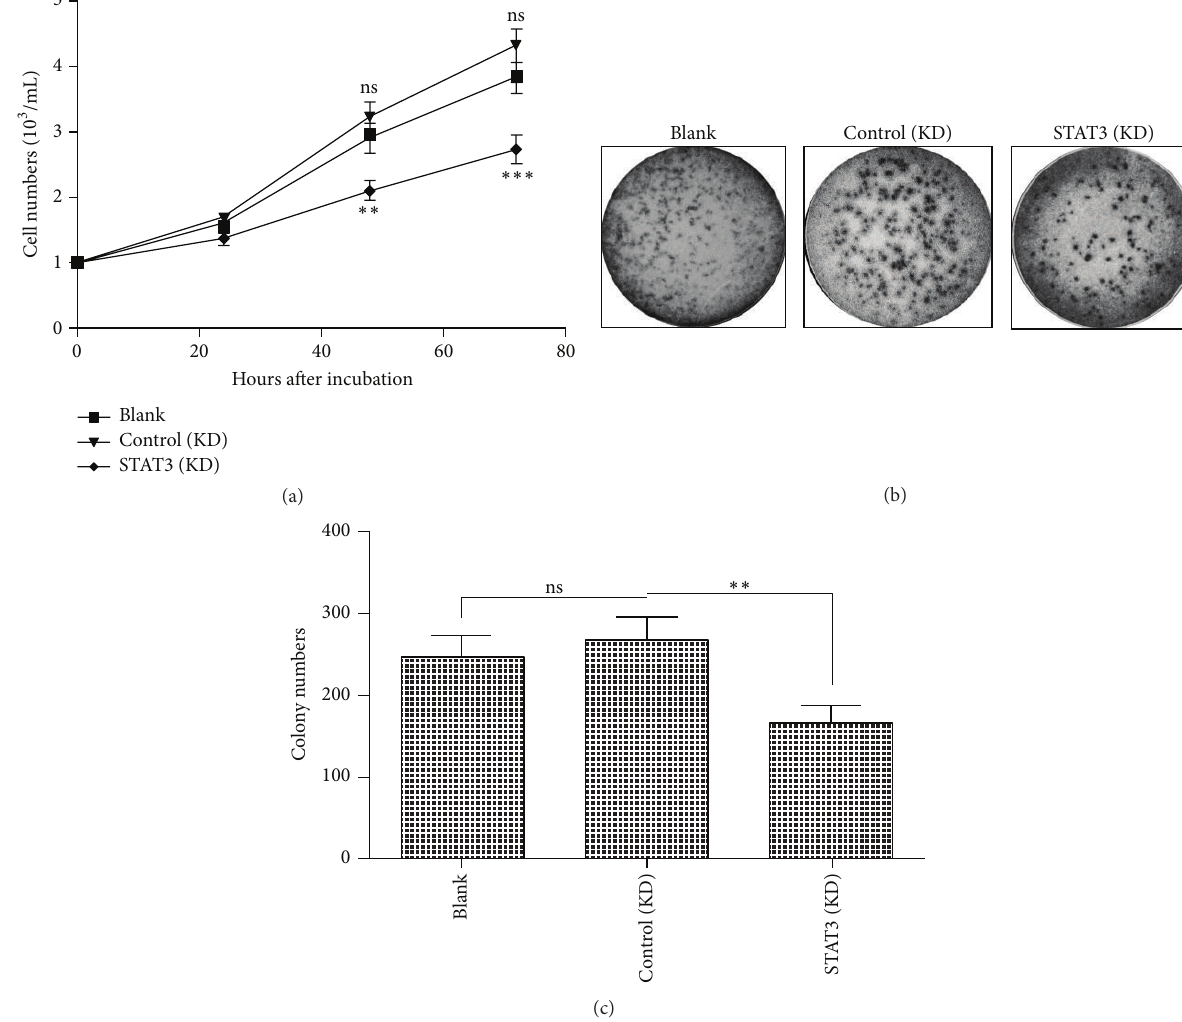
Figure 4: Positive regulation of STAT3 in the proliferation of Caco-2 cells. (a) Growth curve of blank Caco-2 cells (as blank control), Caco- 2 cells which were transfected with sh-STAT3 (STAT3 (KD)), or control shRNA (control (KD)), and the cell number was counted in each group after an incubation of 24, 48, or 72 hours; (b) colony forming assay of blank, STAT3 (KD), and control (KD) Caco-2 cells after 48-hour incubation; (c) colony counting of the three groups of Caco-2 cells. Results were repeated in triplicate independently, ∗∗ represented 𝑝 < 0.01 , ∗ ∗ ∗ represented 𝑝 < 0.001 , and ns represented no